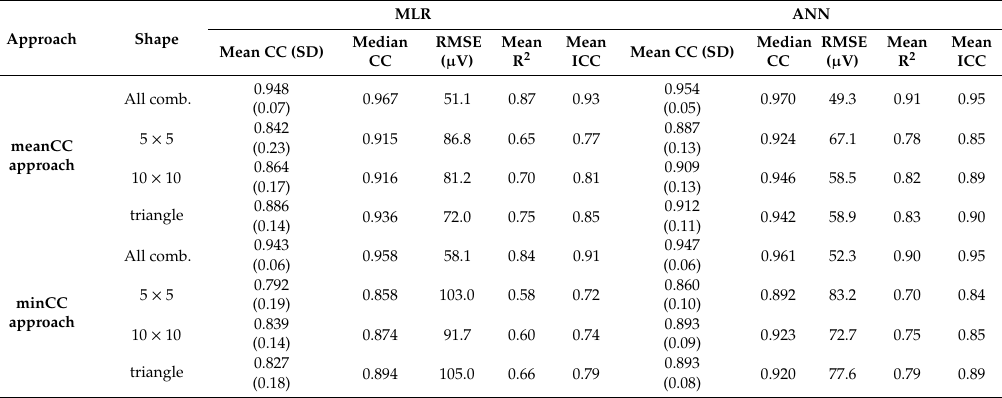
Table 3. Reconstruction performance of the electrode combination that showed the highest correlation coe ffi cient (CC).